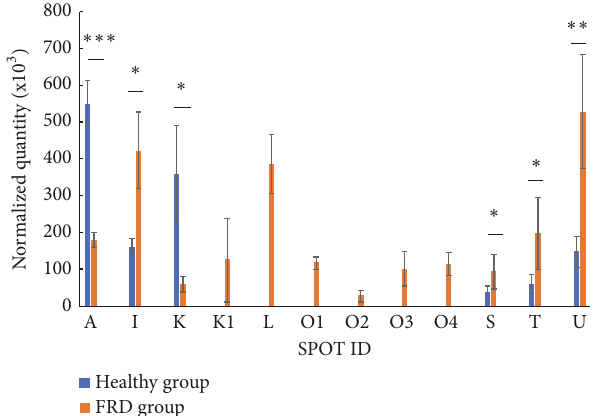
Figure2:Quantitativeanalysisofeachspotinthehealthygroupand in the FRD group. Data are shown as mean values ± SE. ∗∗∗ P < 0.005; ∗∗ P < 0.01; ∗ P <